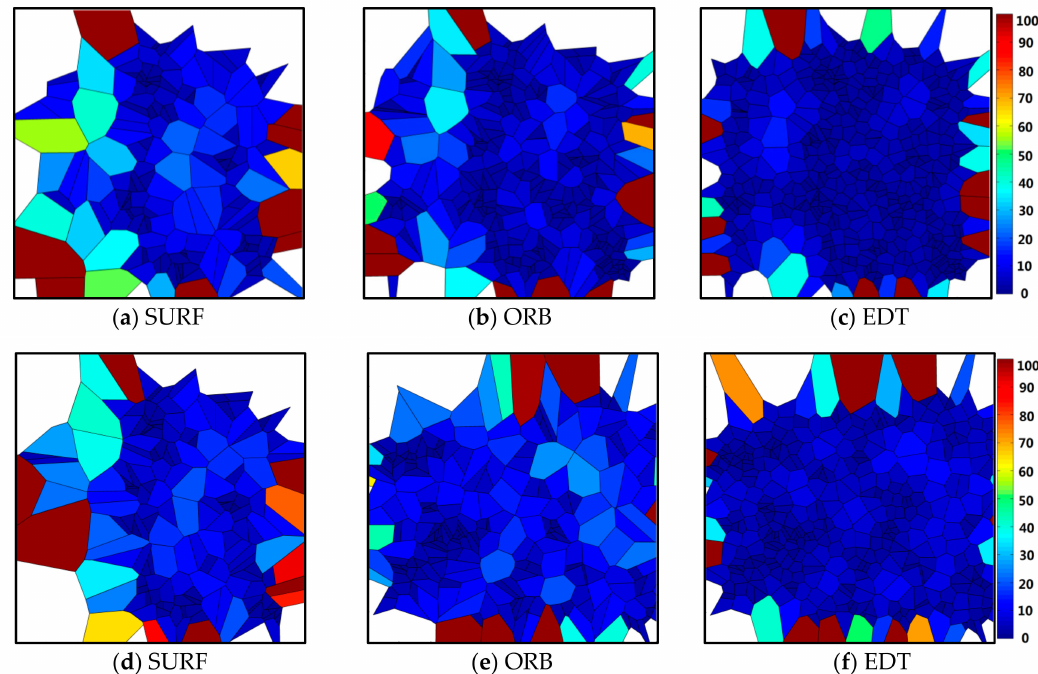
Figure 11. Spatial Density of feature points tracking with the SURF, ORB, and EDT methods. Results of ( a ) SURF, ( b ) ORB and ( c ) EDT methods for case 1. Results of ( d ) SURF, ( e ) ORB and ( f ) EDT methods for case